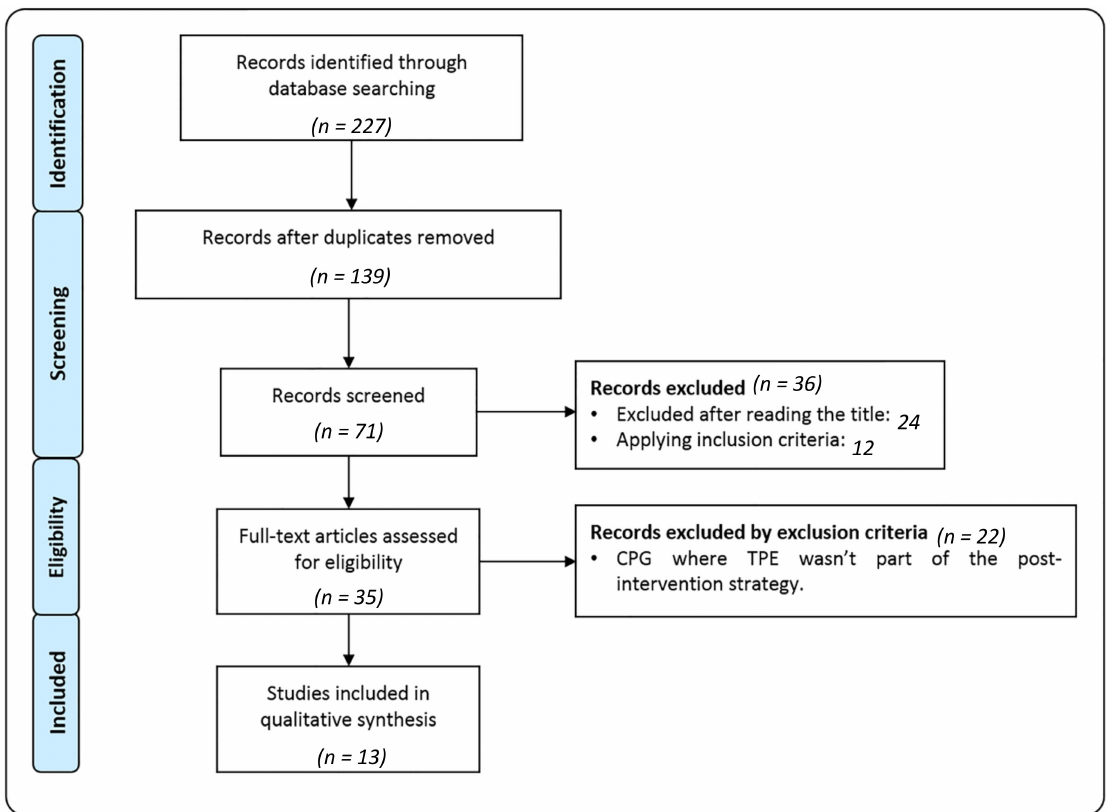
Figure 1. Flowchart of search results and filtering of the documents selected in this